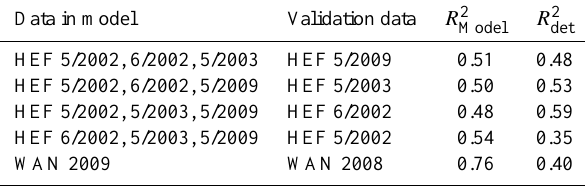
Table 5. Inter-annual consistency for HEF and WAN. The first col- umn lists the data which were used to fit the model (model param- eters d E , SL, NO). The second column shows the data set used for the validation. R 2 is the R 2 of the model, and R 2 the coeffi- Model det cient of